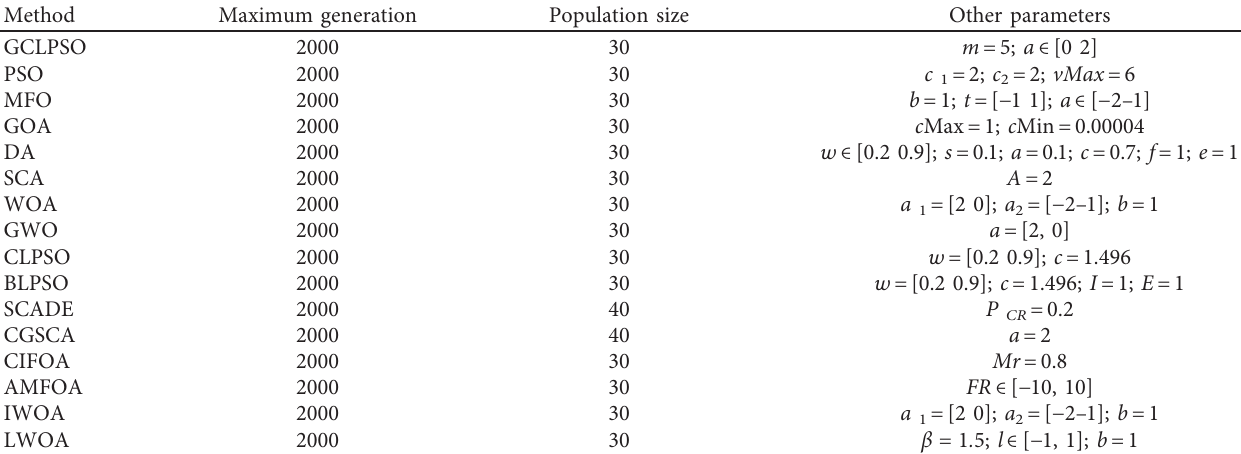
Table 3: Parameter setting for compared algorithms.